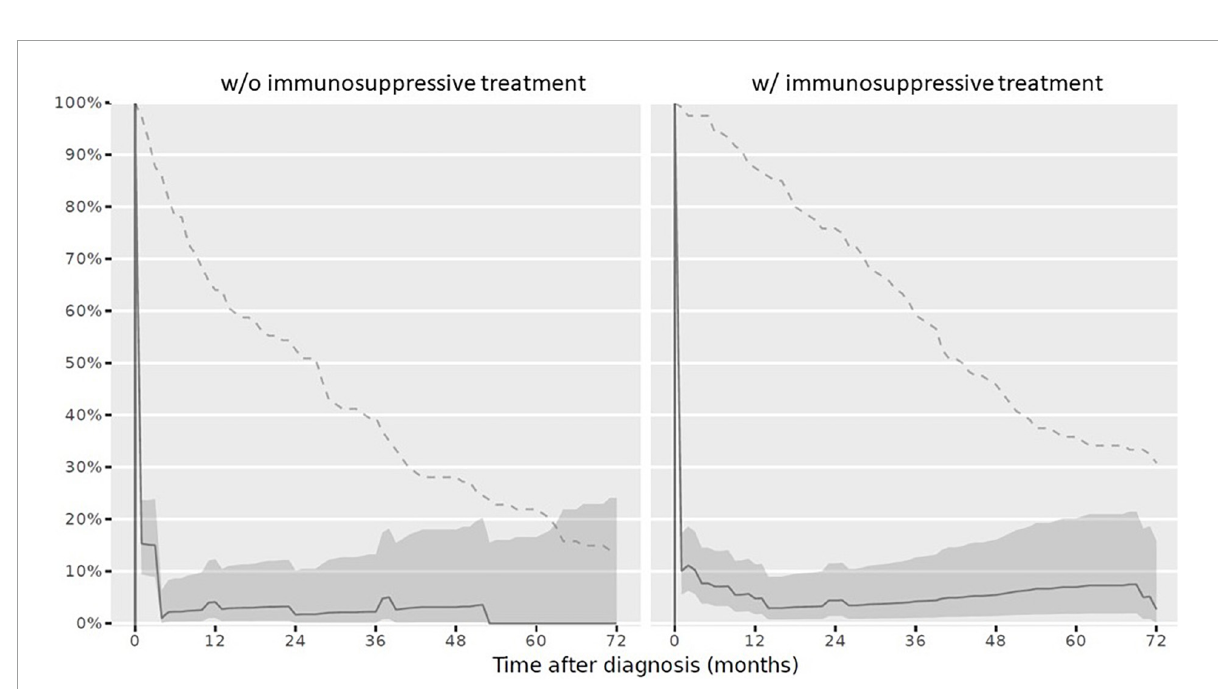
FIGURE4 Complete vaccination status according to the specific additional vaccination recommendations in children after PRD diagnosis. Legend: y-axis Completeness (% patients vaccinated completely, solid line with 95% confidence interval); x-axis Sample size (% patients available, dashed line). PRD pediatric patients with rheumatic disease. w/o, without immunosuppressive treatment w/ with immunosuppressive